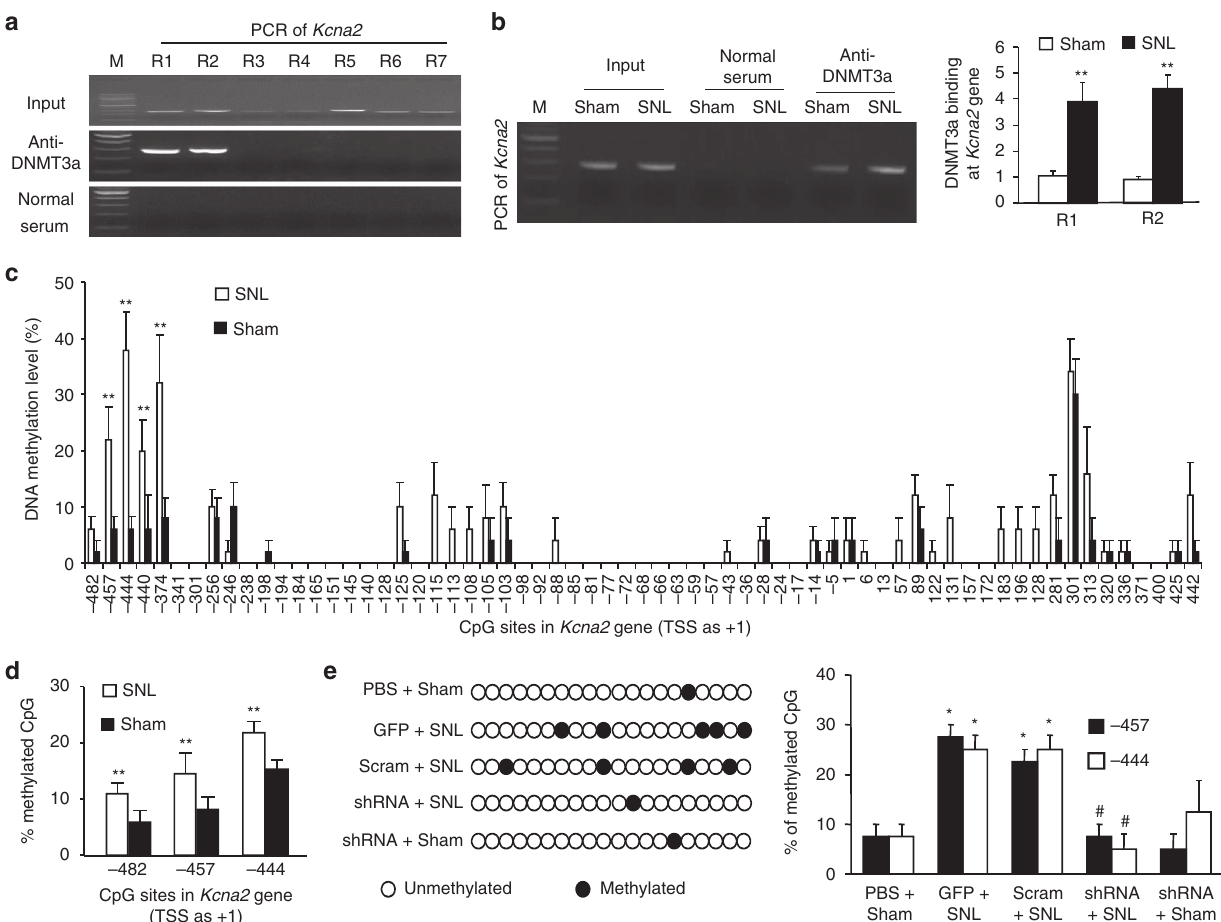
Figure 9 | DNMT3a is required for the nerve injury-induced increase in Kcna2 DNA methylation in rat injured DRG. ( a ) Two regions (R1, (cid:2) 663/ (cid:2) 389; R2, (cid:2) 491/ (cid:2) 199), but not other regions (R3, (cid:2) 237/ þ 42; R4, þ 20/ þ 278; R5, þ 185/ þ 464; R6: þ 411/ þ 649; R7: þ 680/ þ 928), from the Kcna2 gene were immunoprecipitated by rabbit anti-DNMT3a (not by rabbit normal serum) in rat lumbar DRG. Input, total purified fragments. M, ladder marker. n ¼ 3 repeats. ( b ) DNMT3a binding to R1 and R2 regions within the Dnmt3a gene in the ipsilateral L5 DRG of rats on day 7 post-SNL or sham surgery. Left: the binding of Dnmt3a to the R1 region of Kcna2 gene. Right: the quantitative analysis of the binding. n ¼ 3 repeats (3 rats/repeat)/group. ** P o 0.01 versus the corresponding sham group by two-tailed unpaired Student’s t -test. ( c , d ) The increases in the levels of DNA methylation at (cid:2) 457, (cid:2) 444, (cid:2) 440, and (cid:2) 374 CpG sites by bisulfite clone-sequencing assay ( c ) and at (cid:2) 482, (cid:2) 457, and (cid:2) 444 CpG sites by bisulfite pyro-sequencing assay ( d ) from (cid:2) 540 to 500bp sites of Kcna2 gene consisted of 65 CpG sites in the ipsilateral L5 DRG of rats on day 7 post-SNL. n ¼ 3 repeats (6 rats/repeat)/group. ** P o 0.01 versus the corresponding sham group by two-tailed unpaired Student’s t -test. ( e ) The percentages of methylation at (cid:2) 457 and (cid:2) 444 CpG sites of the Kcna2 gene in the ipsilateral L5 DRG on day 7 post-SNL or sham surgery from five groups as indicated. GFP: AAV5- GFP . scram: AAV5- Dnmt3a scrambled shRNA. shRNA: AAV5- Dnmt3a shRNA. Left: Representation of a single cloned allele per group at the -457 CpG site. Right: Statistical analysis at (cid:2) 457 and (cid:2) 444 CpG sites. n ¼ 3 repeats (3 rats/repeat)/group. One-way ANOVA (methylation versus. group) followed by post hoc Tukey test, F group (3, 19) ¼ 15.8 for (cid:2) 457 site and F group (3, 19) ¼ 6.4 for (cid:2) 440 site. * P o 0.05 versus the corresponding PBS plus sham group. # P o 0.05 versus the corresponding GFP plus SNL